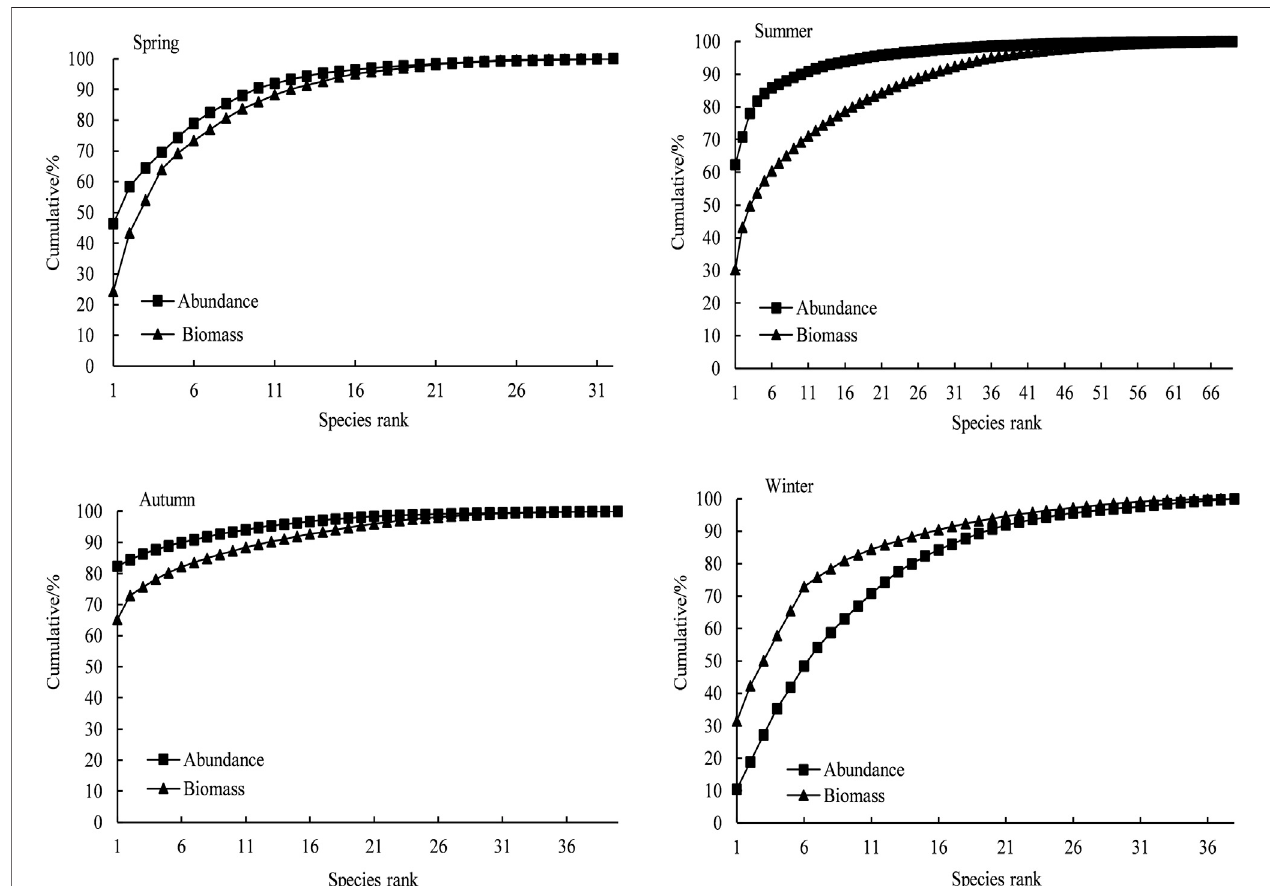
FIGURE 3 | ABC curves of fi sh community in every season in Daya